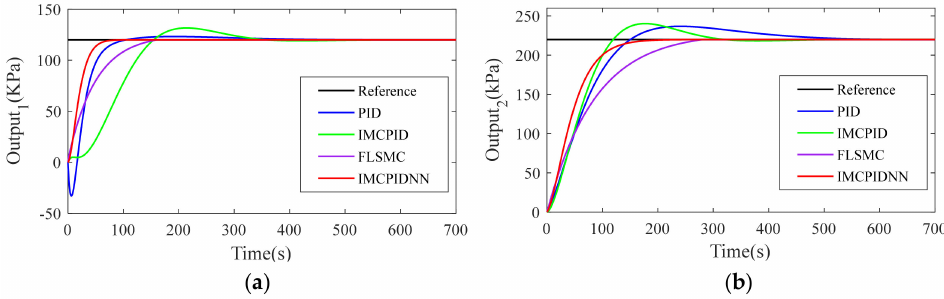
Figure 6. Comparison of step responses with concurrent changes in set-points: ( a ) Output1; ( b ) Output2.